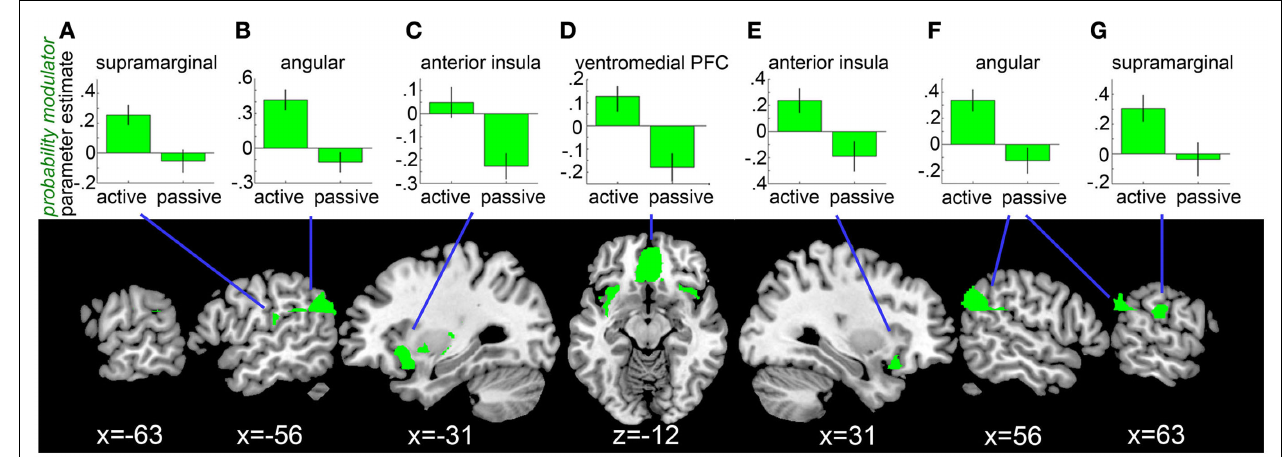
chances of winning during active versus passive bet selection. Results are displayed at P < 0.05, FDR-corrected. Bar graphs show parameter estimates for the probability of winning modulator in the two choice conditions at peak voxels [ (A,G) : supramarginal gyrus, (B,F) : angular gyrus, (C,E) : anterior insula, (D) : ventromedial prefrontal cortex]. Error bars represent SEM.